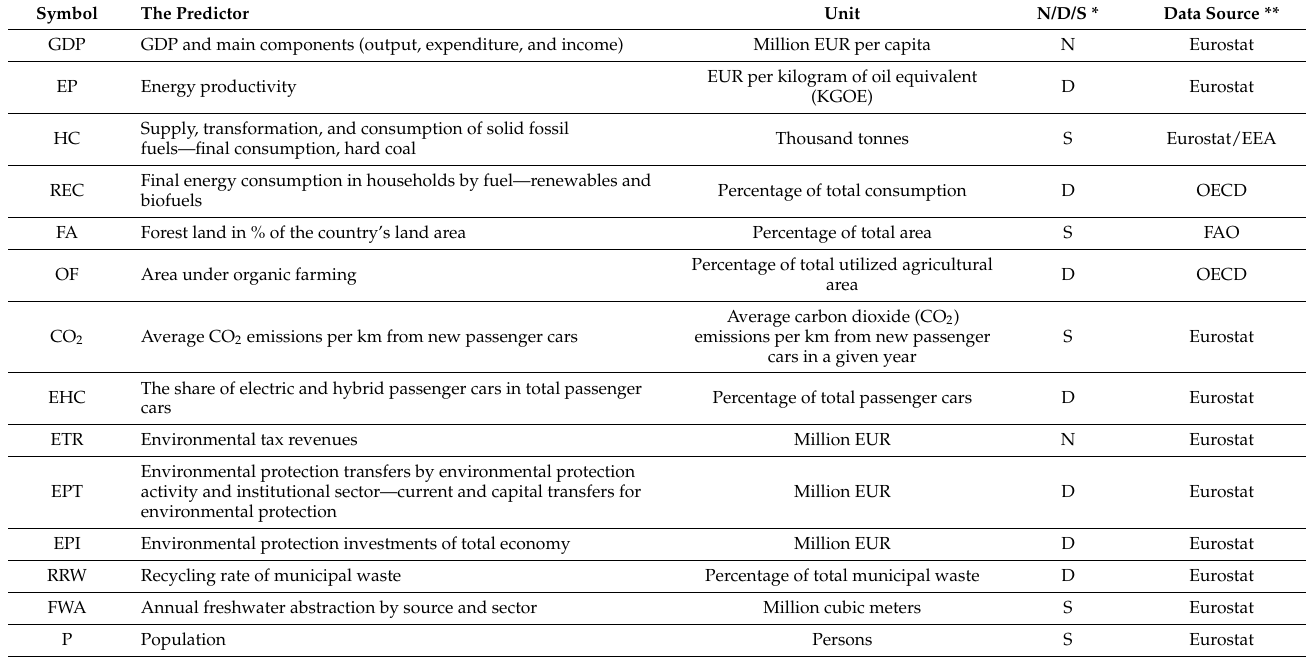
Table 3. Set of variables shaping the greenhouse gas emissions in EU countries.